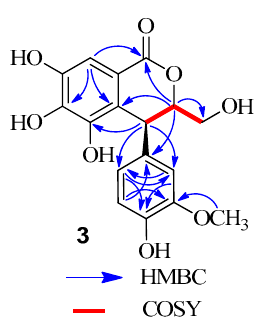
Figure 6. Key HMBC and COSY correlations of 3 . Figure 5. Key HMBC and COSY correlations of 3